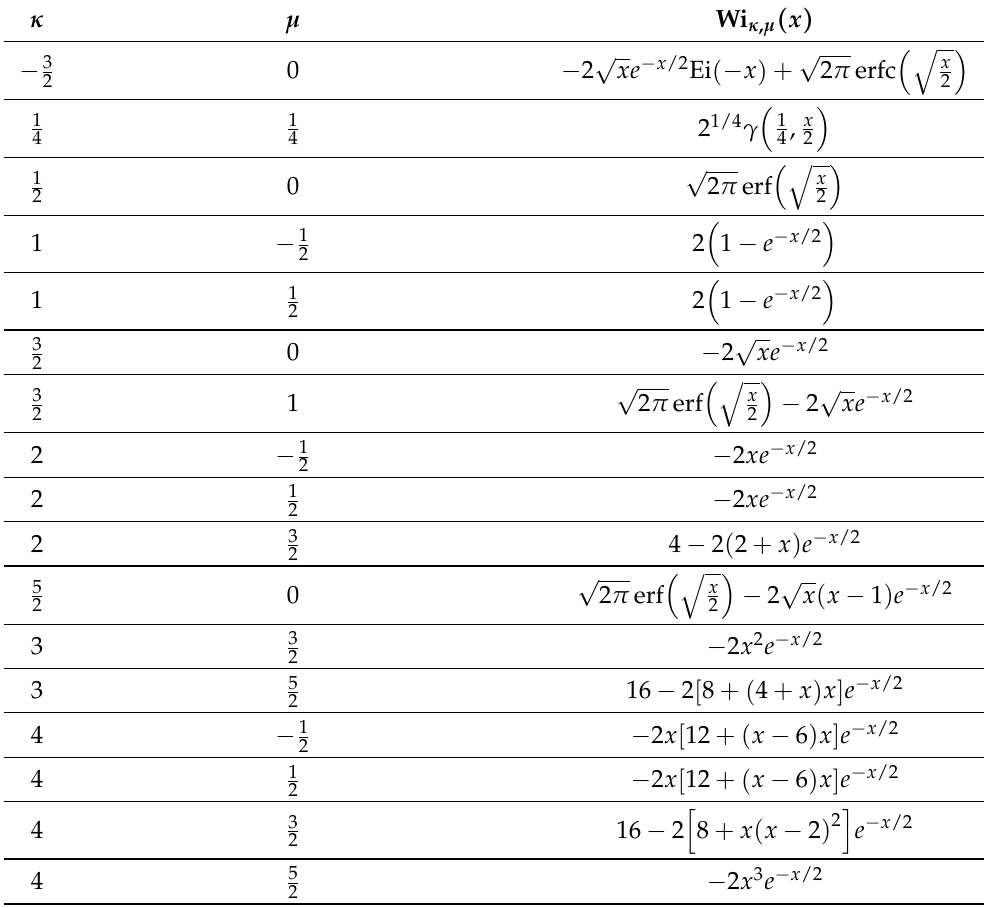
Table 8. The integral Whittaker functions Wi κ , µ derived for some values of parameters κ and µ by using (18) and (20).